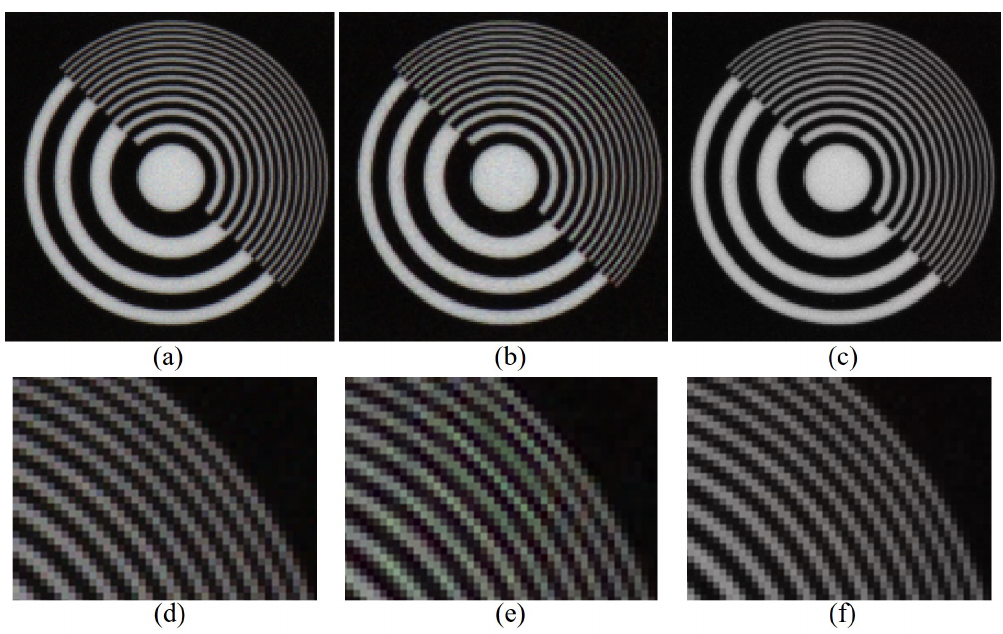
Figure 1. Effect of the rank minimization-based global interpolation, as described in (7). Experimental results on a partially cropped photo image of the ISO 12233 Resolution Chart. ( a ) Original; ( b ) Reconstructed using residual interpolation [14]; ( c ) Reconstructed by (7); ( d ) Enlarged region of ( a ); ( e ) Enlarged region of ( b ); ( f ) Enlarged region of ( c ).